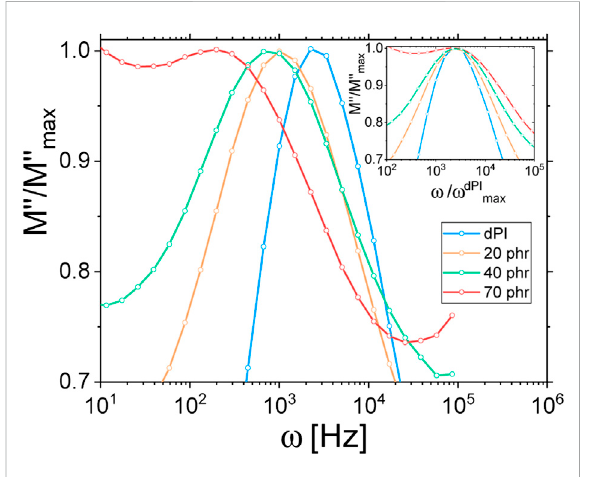
FIGURE 3 α -relaxation peak of Coupsil samples measured by dielectric spectroscopy at 233 K.